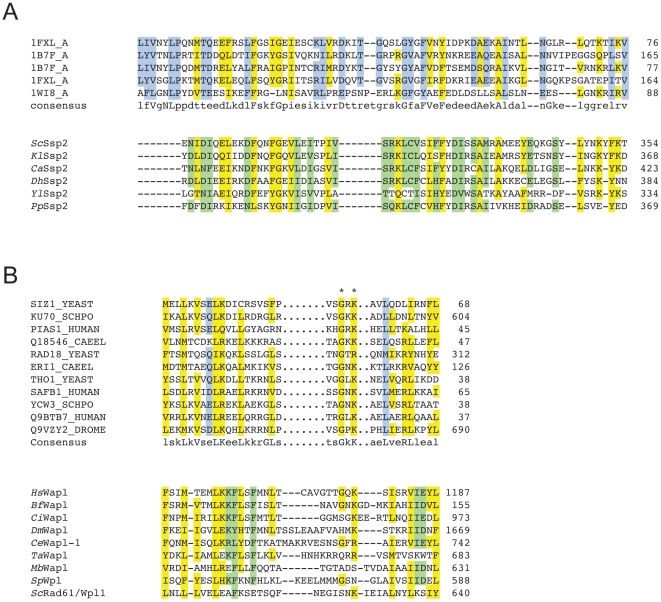
Multiple sequence alignments of remotely conserved domains in proteins associated with mitosis and meiosis.(A) Multiple sequence alignment of the Ssp2 family with the RRM_1 domain. (B) Multipe sequence alignment of the Wapl/Rad61 family with the SAP domain family. Residues that are conserved between the two families are highlighted in yellow, those found in only one of them are highlighted in blue and green, respectively. Essential, functional residues retrieved from the CD database are indicated by hash keys, those retrieved from literature (SAP domain) with stars. Accession numbers of sequences can be found in Supplemental Table S7.